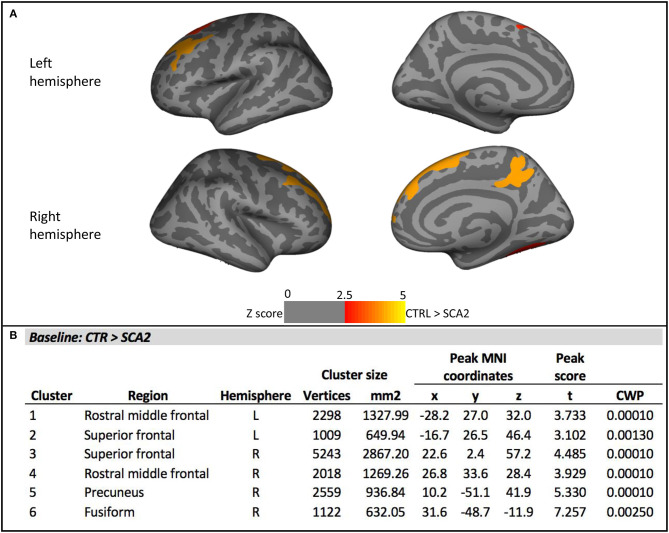
Vertex-wise analysis of cortical thickness at baseline. (A) Significant cortical thickness changes in the SCA2 patients compared to the healthy controls (CTR). All results were reported with p < 0.01, corrected for multiple comparisons using a Monte Carlo cluster-based simulation. Clusters color-coded in red indicate significantly decreased cortical thickness in the patient group compared to control (CTR). (B) Clusters showing significant cortical thickness changes in the SCA2 patients compared to the healthy CTR. CWP, p-value of the cluster (cluster-wise p-value); L, left; R, right. Peak coordinates are reported according to MNI305 space.